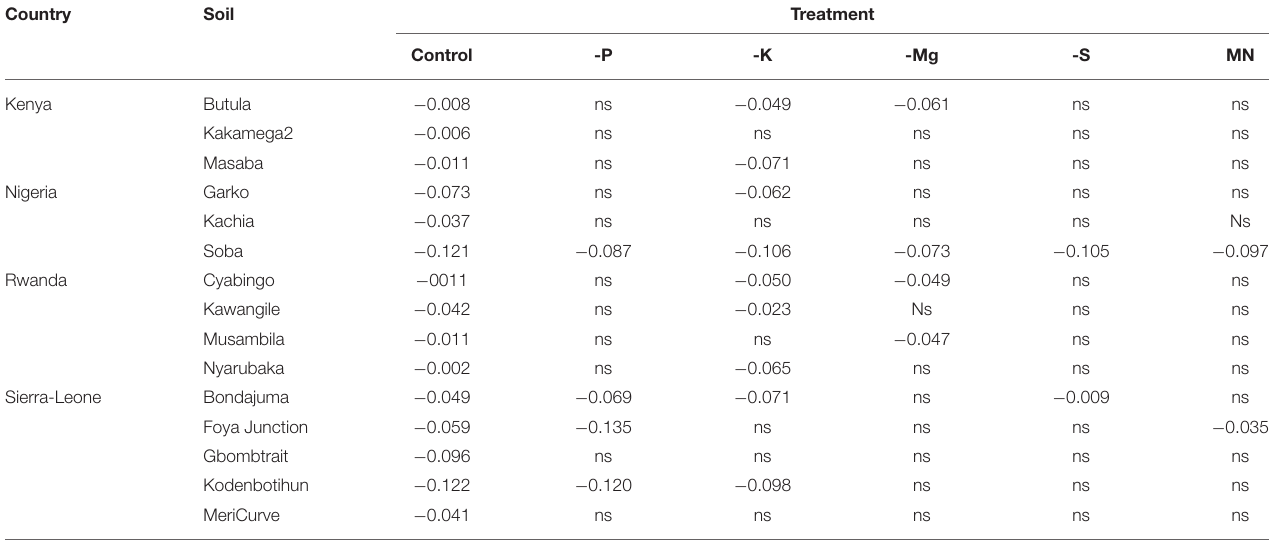
TABLE 6 | Averages of the sufficiency difference of control and omitted nutrients (relative to complete) ordered per experimental soil and per P values. Country